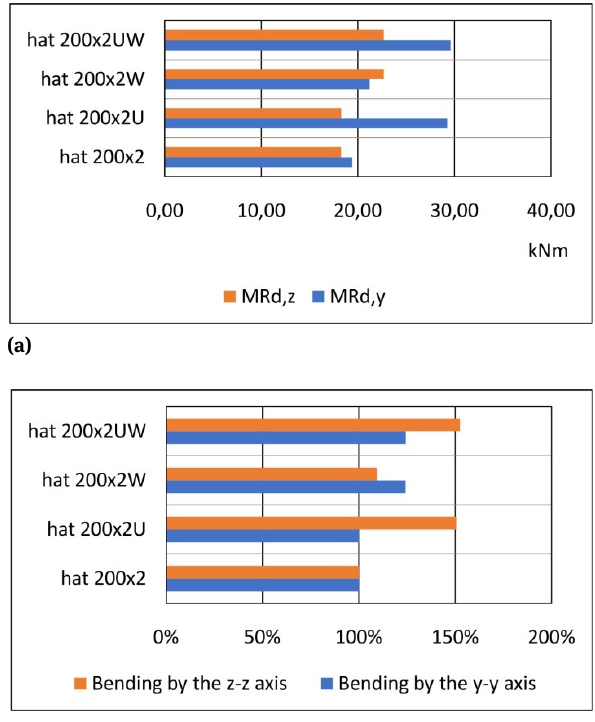
Figure 10: a) Resistance of cross-section in bending, b) percentage increase bending capacity of cross-section in relation to the non- stiffened